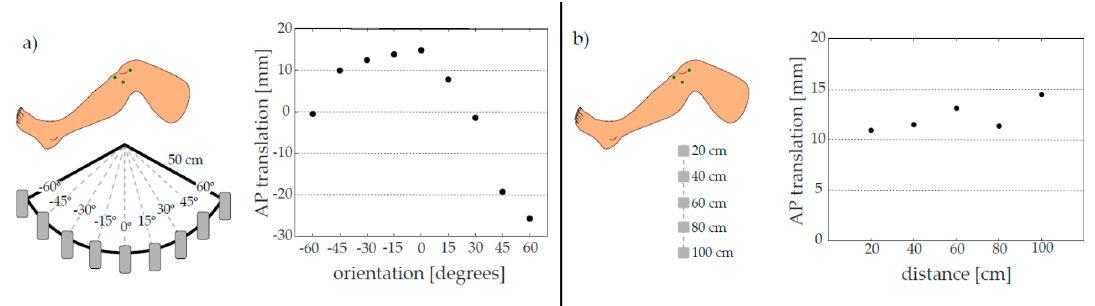
Figure 5 . ( a ) AP translation as a function of the orientation angle of the camera with respect to the sagittal plane. ( b ) AP translation as a function of the distance of the camera plane.